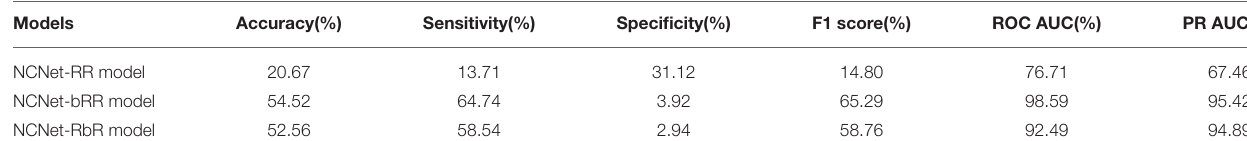
TABLE 2 | Percentage of targets that perform better with NCNet models than r-DanQ model.